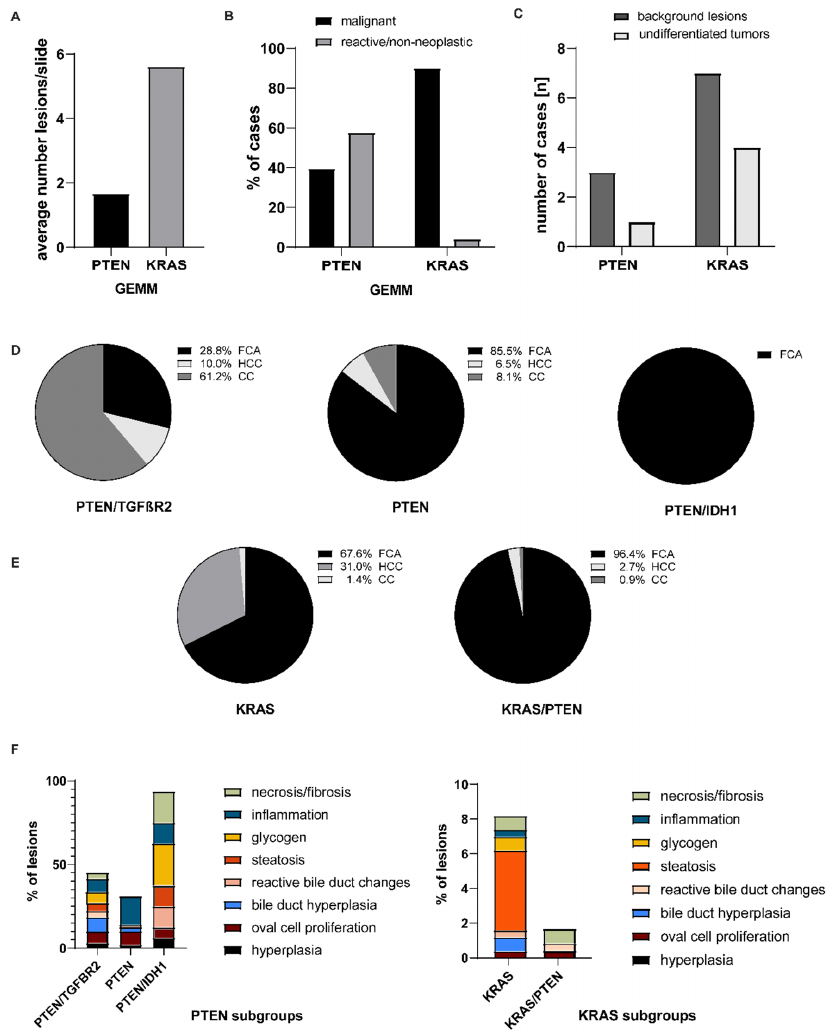
Figure 4. Distribution of diagnosis according to the genetic background. ( A ) Average number of microscopically detectable lesions; ( B ) percentage of non-neoplastic and neoplastic lesions; ( C ) distribution of background lesions and undifferentiated tumors in PTEN and KRAS models; ( D ) distribution of malignant tumors in PTEN mutated subgroups; ( E ) distribution of malignant tumors in KRAS mutated subgroups. ( F ) Distribution of non-neoplastic lesions in PTEN and KRAS subgroups.